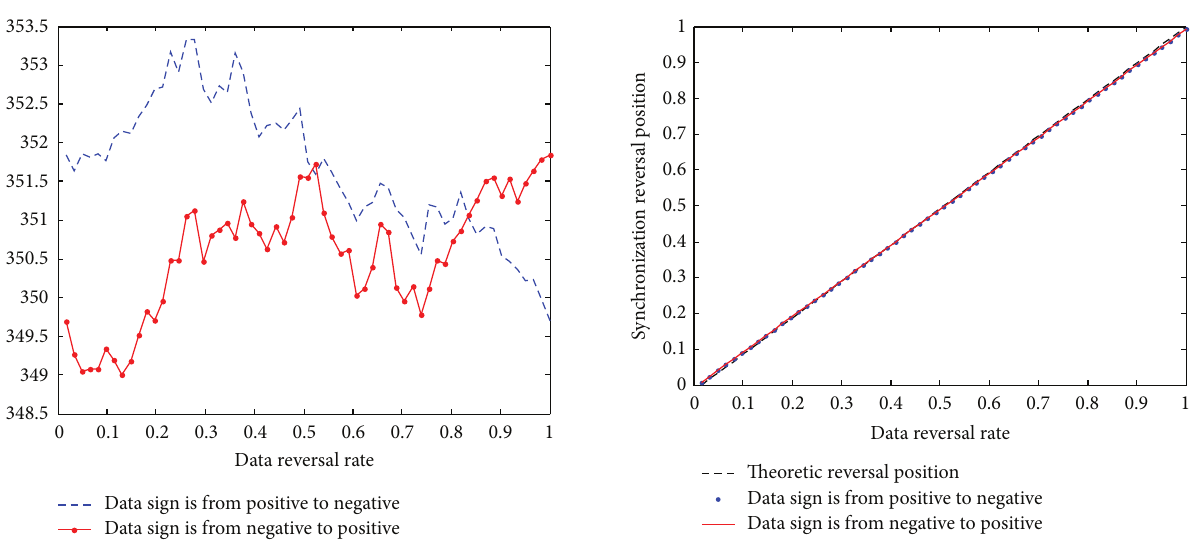
Figure 2: The reversal position change with changing data reversal rate.